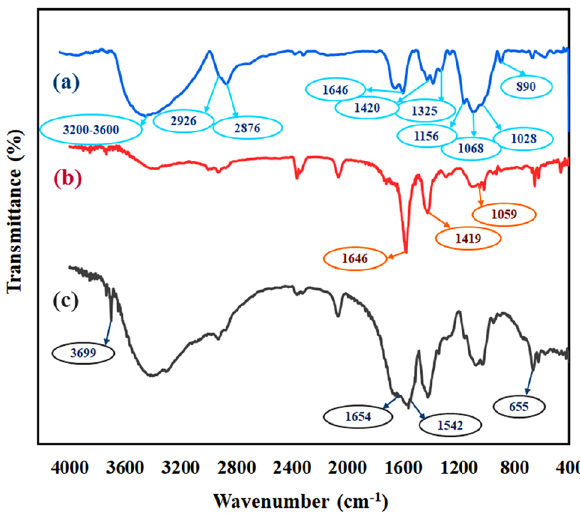
Figure 2. FT-IR spectra of ( a ) chitosan biopolymer, ( b ) CTT-CS hydrogel, ( c ) CTT-CS/SF/Mg(OH) 2 nanobiocomposite